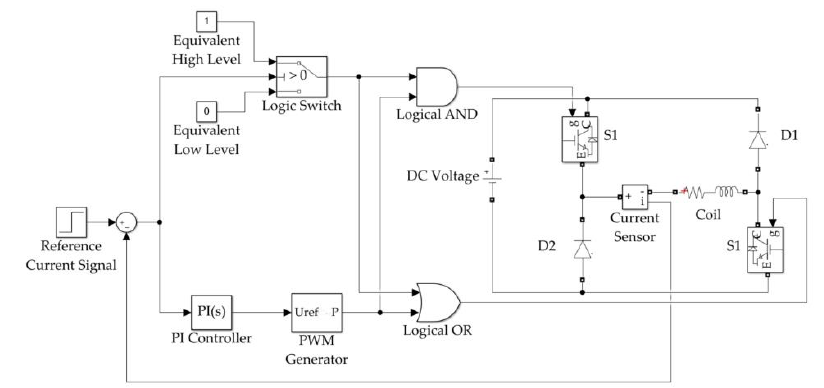
Figure 10. Current control loop with a half-bridge SPA.